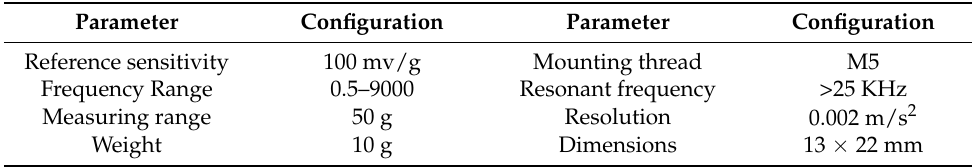
Table 8. Parameter table for the INV9822 acceleration sensor.